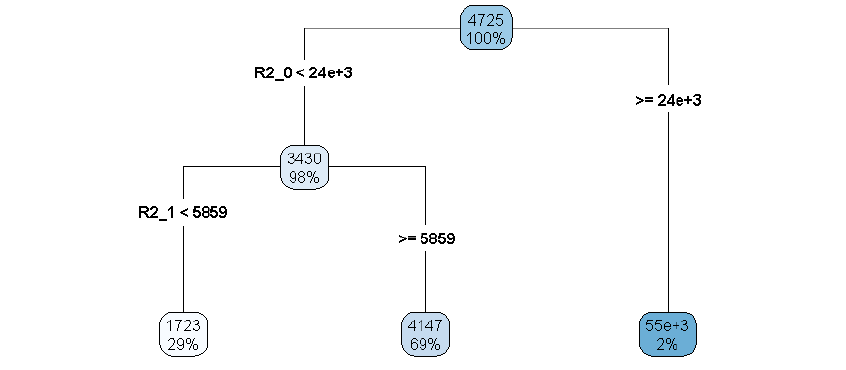
Figure 3. Severity model: pruned regression tree for claims in leaf 3 of the frequency